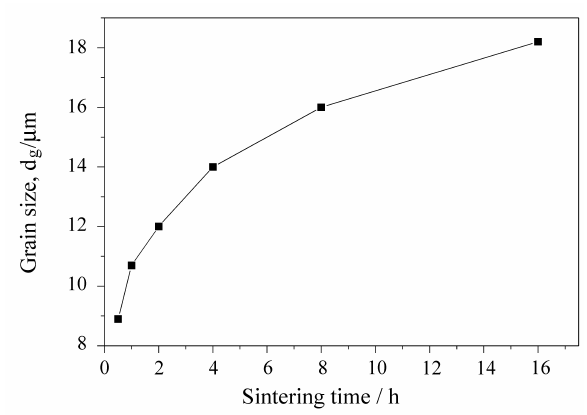
Figure 6. Grain size growth dependence with sintering time at 1610 °C.